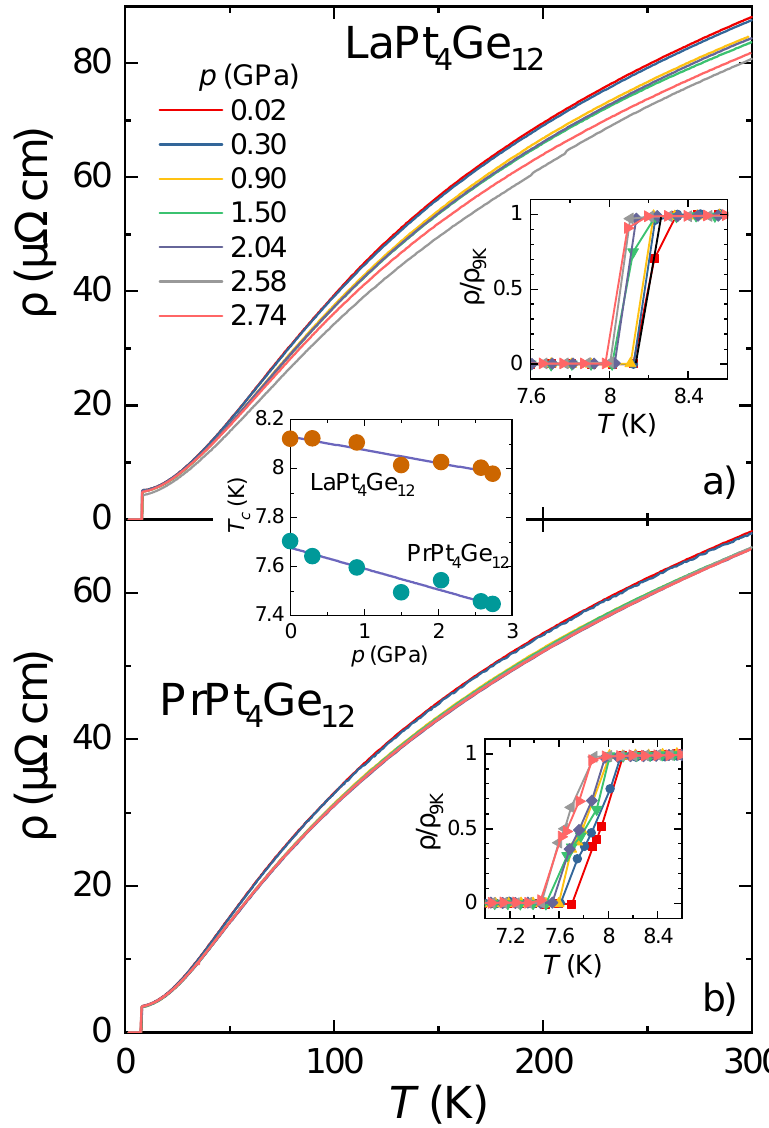
Figure 1. Electrical resistivity for ( a ) LaPt 4 Ge 12 and ( b ) PrPt 4 Ge 12 single crystals under various hydrostatic pressures. The corresponding insets depict the resistivity normalized by its value at 9 K. The central inset shows the pressure dependence of T c . The lines are linear fits to the data. See text for